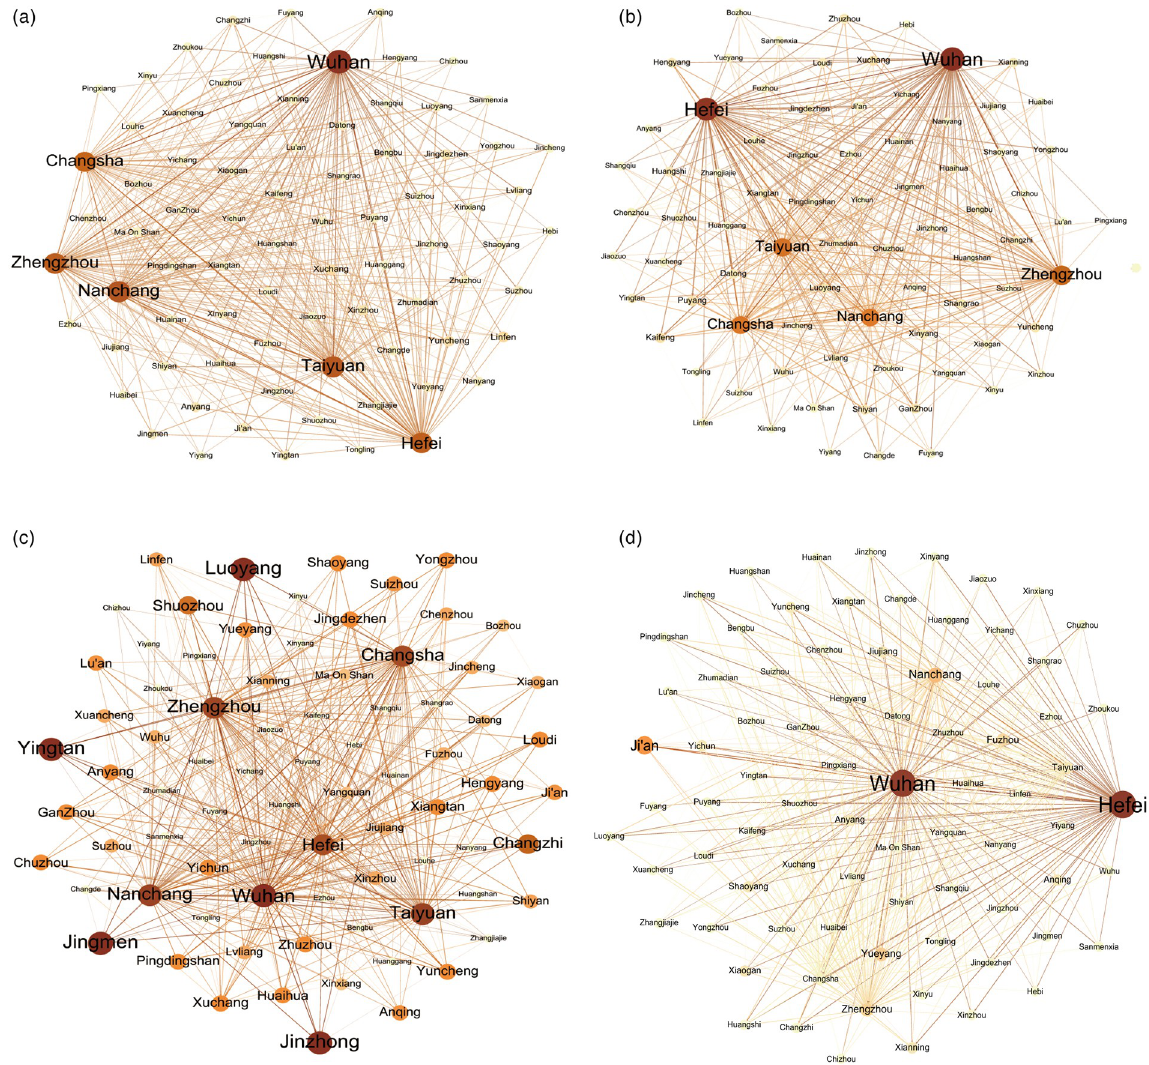
Fig 3. Complex-network topology structure of freight demand. a. Degree centrality. b. Weighted degree centrality. c. Closeness centrality. d. Betweenness